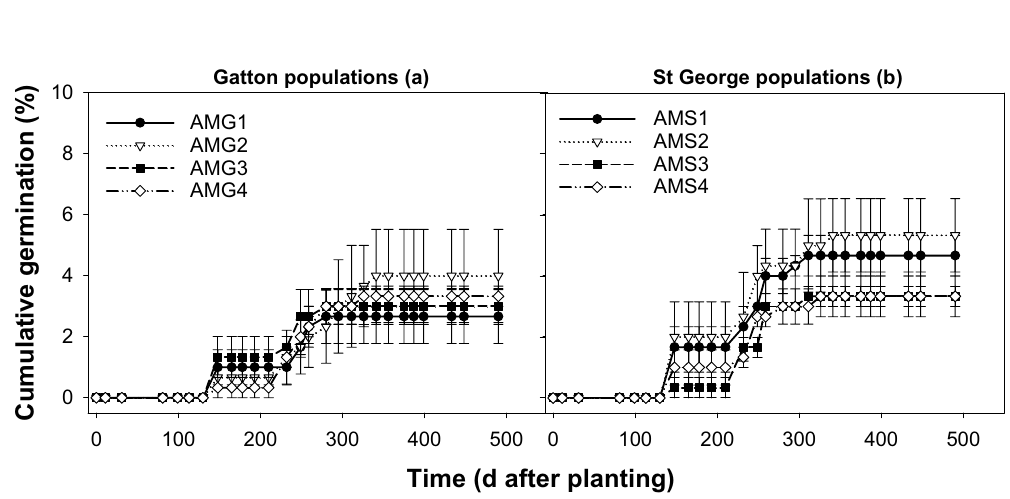
Figure 8. Emergence pattern of Argemone mexicana populations from Gatton (AMG1-AMG4; a) and St George (AMS1-AMS4; b) in trays in trays under a rainfed environment (November 2015 to April 2017), symbols correspond to mean and error bars are the standard error of means (n =